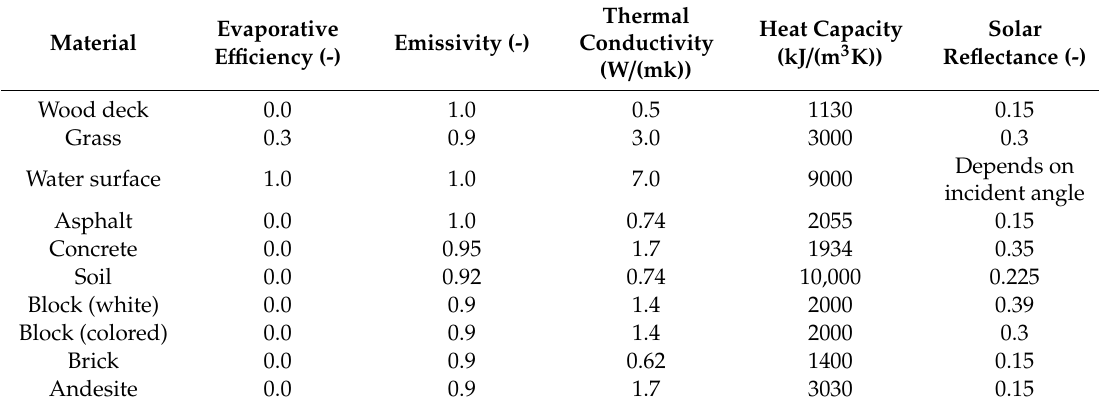
Table 2. Properties of land cover materials.